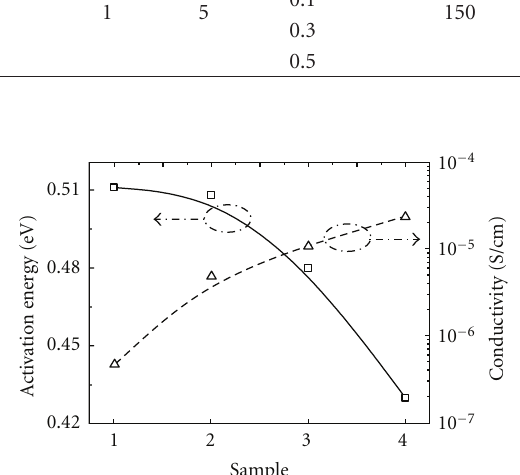
Figure 3: Dark conductivity and activation energy of p-type a-Si:H prepared at various B 2 H 6 flow